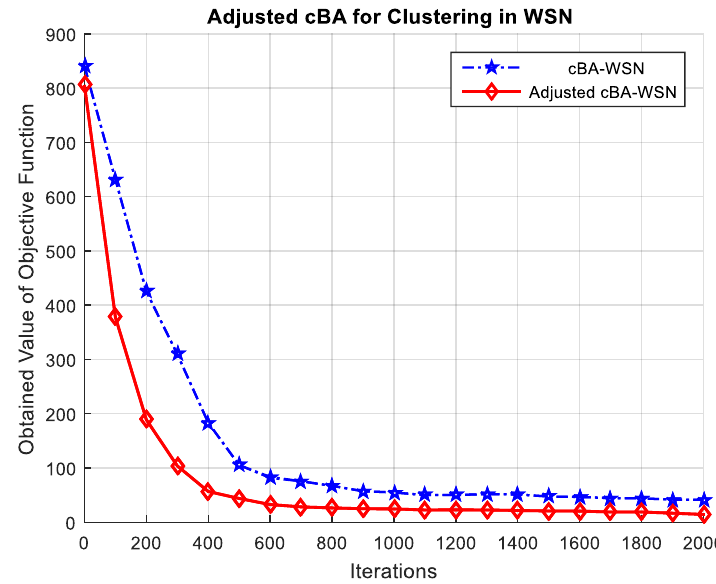
Figure 6. Comparison of converging curves of the cBA-WSN (with adjusted cluster size for BAs with altered loudness) and the cBA-WSN (with no adjusted).